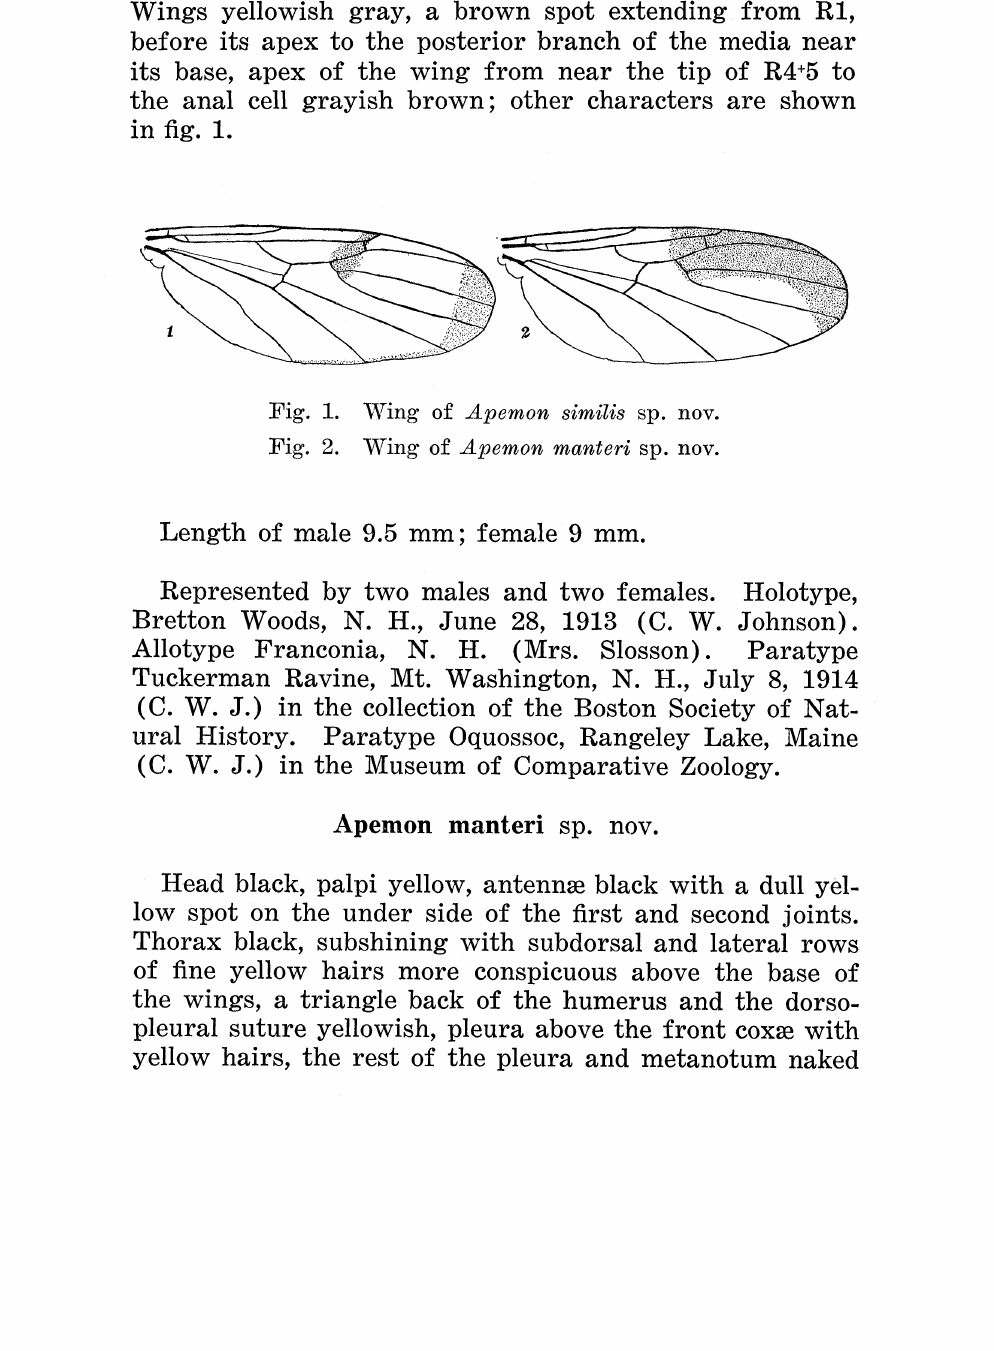
:Fig. 1. Wing of Apemon similis sp. nov. :Fig. 2. Wing of Apemon manteri sp.